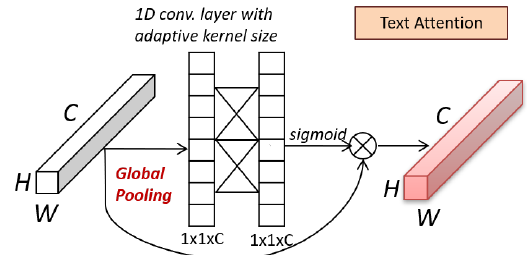
Figure 2. Design of the Text Attention